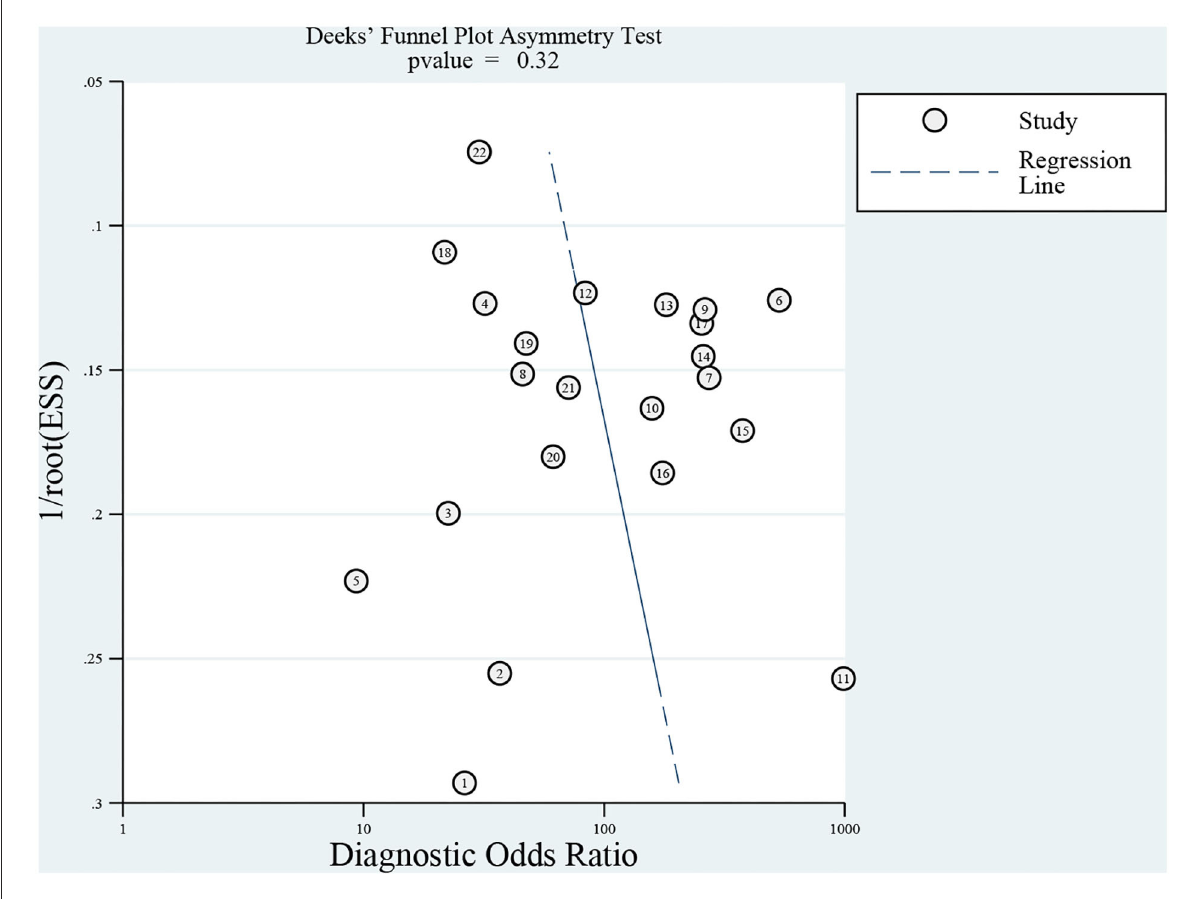
FIGURE3 Funnel plot of publication